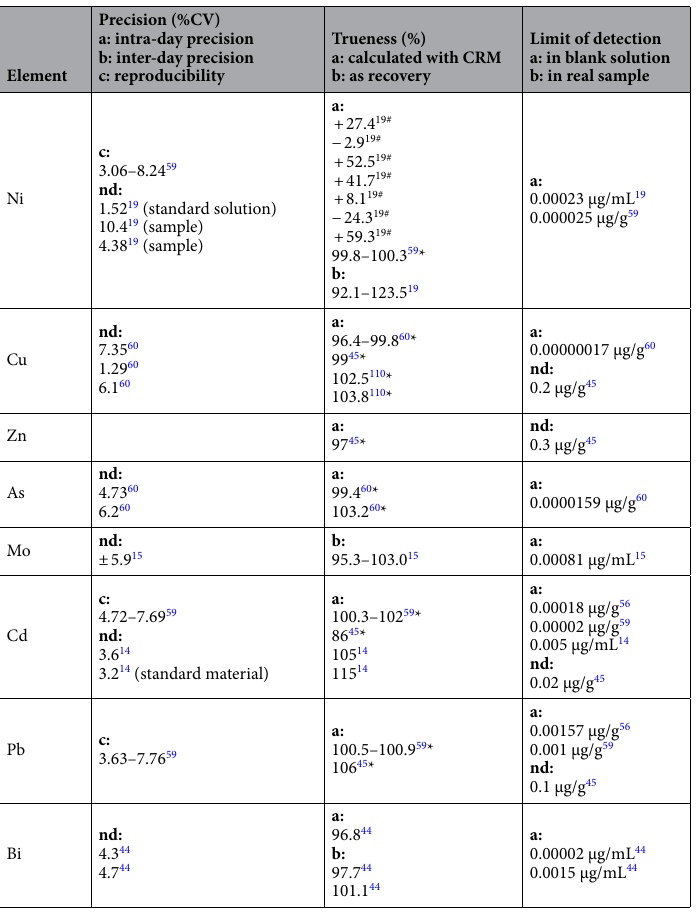
Table 2. Values of precision, trueness and detection limit for different elements determined by using AAS. nd method of parameter determination was not defined; # Trueness expressed as a Bias; *Calculated based on the literature